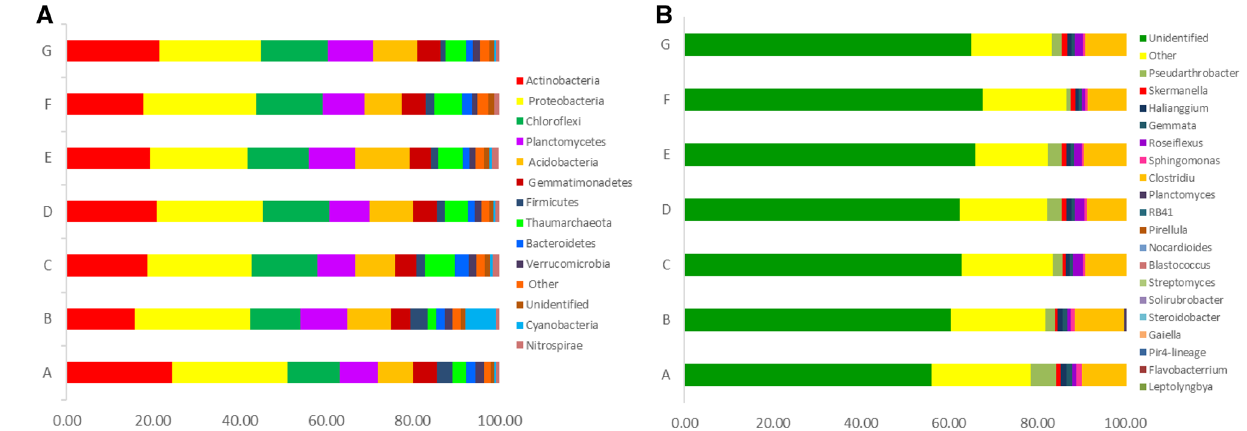
Figure 5. ( A ) Bacterial Phylum of different cropping years based on mean read numbers per sample. ( B ) Bacterial genus of different cropping years based on mean read numbers per sample. ( C ) LDA score of the bacteria of different cropping year. The figure shows species whose LDA Score is greater than the set value ( LDA score > 2, less-strict set to 2; More-strict was set as 4), that is, biomarkers with statistical differences between groups. The length of the bar chart represents the significance of the different